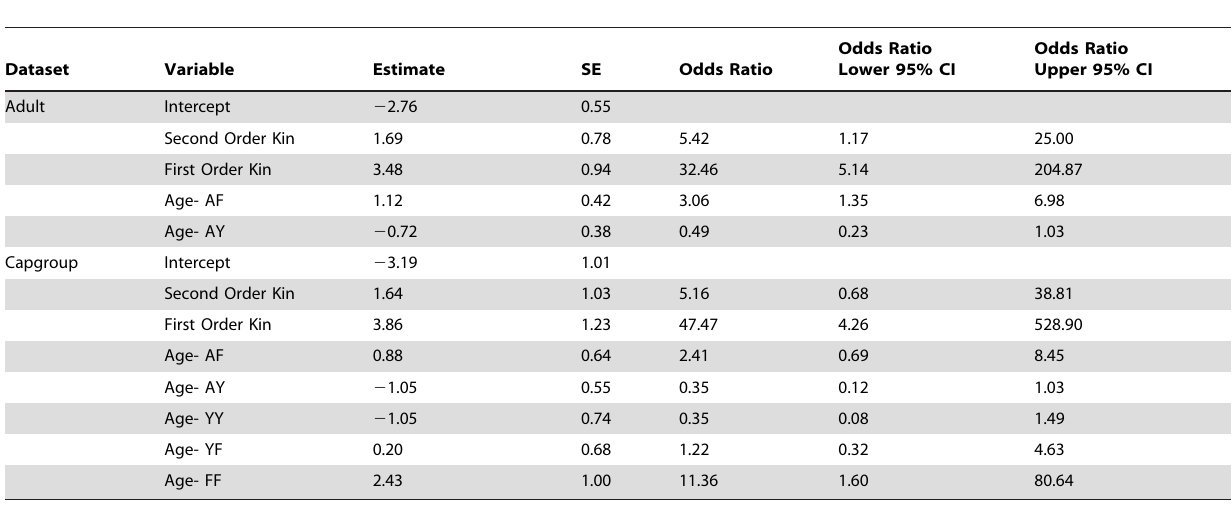
Table 2. Parameter estimates from top models used to predict white-tailed deer spatial overlap in Wisconsin.